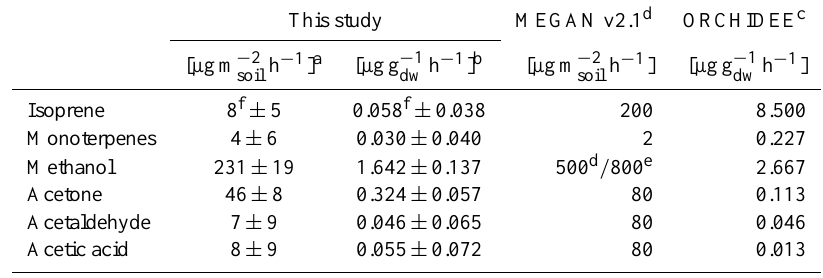
Table 6. SEF recorded at LTO under standard environmental conditions and used in up-scaling models for C4 agricultural crops. This study MEGAN v2.1 d ORCHIDEE